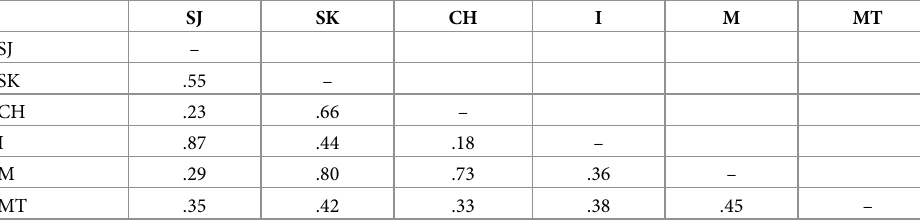
Table 4. Standardized factor correlations for SC subscales and